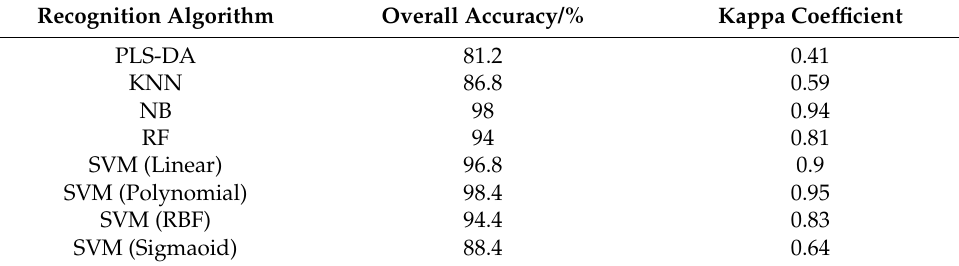
Table 5. Overall classification accuracy and Kappa coefficient.